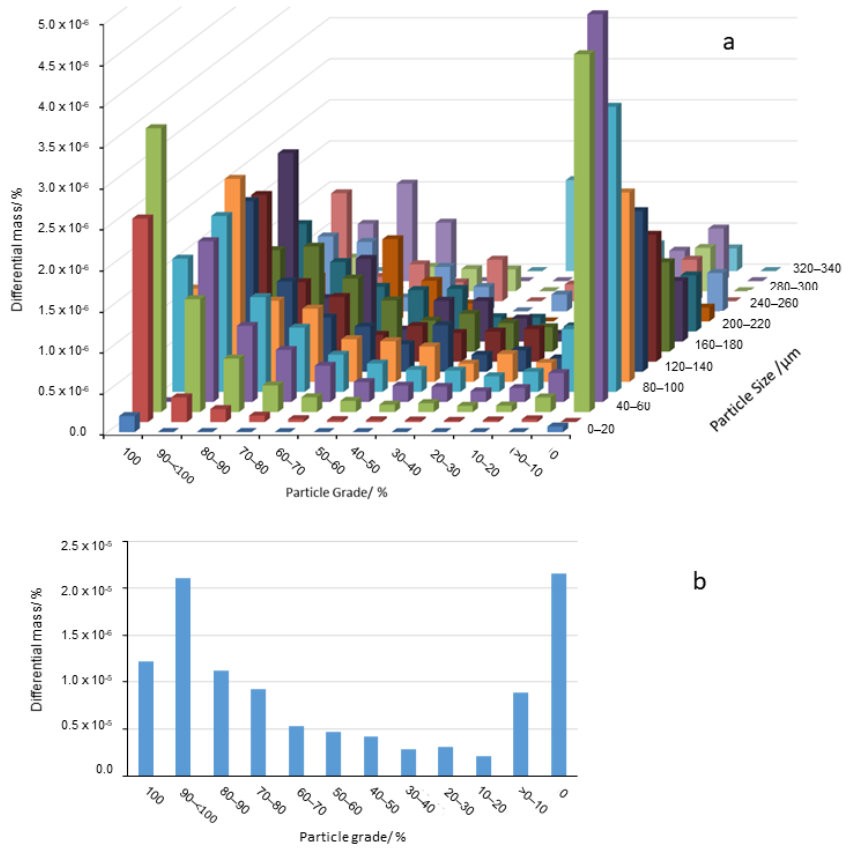
Figure 10. Distribution of cassiterite in the concentrated materials: ( a ) according to particle size and cassiterite grade classes; ( b ) according to the grade.